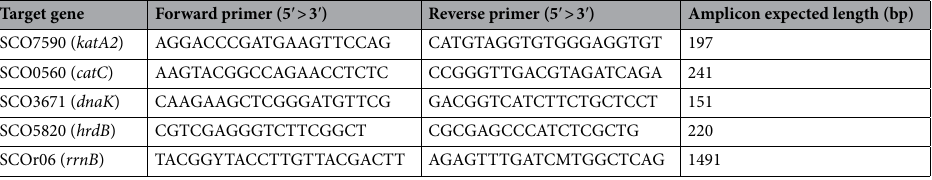
Table 2. List of primers used in this